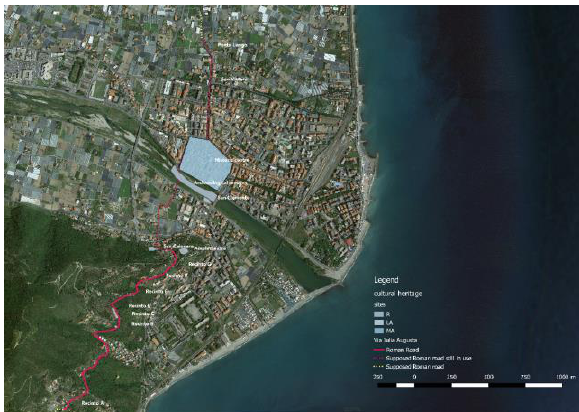
Figure 3. Albenga, the trace of former road Iulia Augusta and its cultural heritage resources